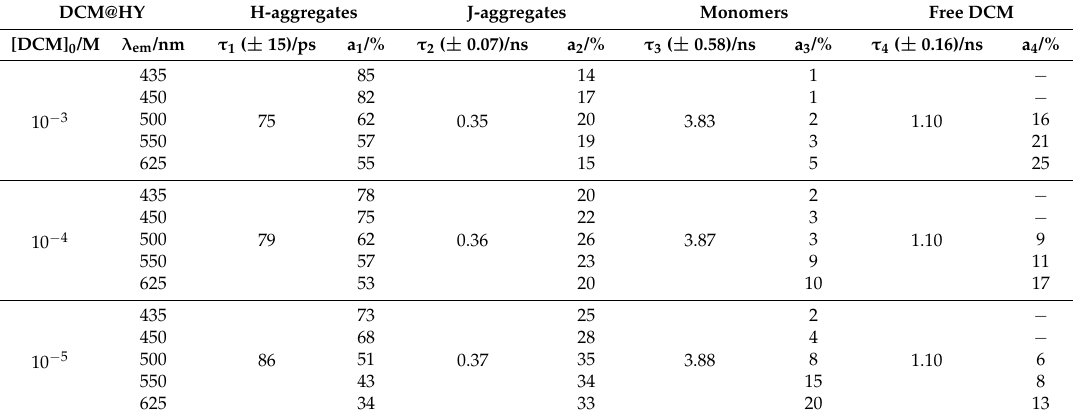
Table 2. Values of time constants ( τ i ) and normalized (to 100) pre-exponential factors (a i ) obtained from the fit of the emission decays of DCM interacting with HY prepared from DCM solutions of 1 × 10 − 3 , 1 × 10 − 4 , and 1 × 10 − 5 M upon excitation at 371 nm and observing at 435 and 450 nm. The estimated uncertainty of the time constants, considering the errors from the experiments as well as those arising from the multi-exponential fit of the signals, was between 13 and